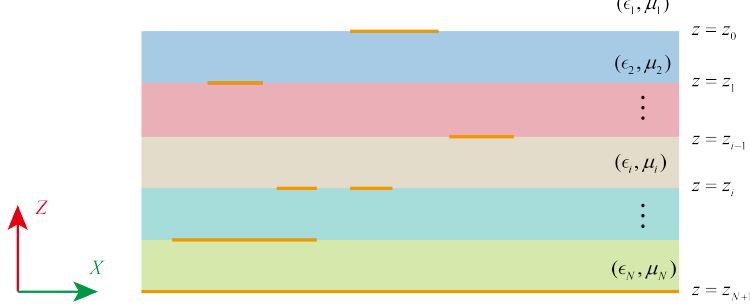
Figure 1. Illustration of the electromagnetic problem in multilayered